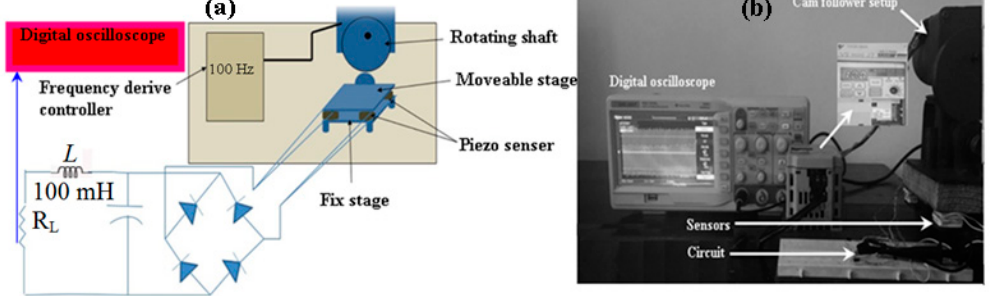
Figure 11. The self-designed cam follower Piezo harvester testing setup. ( a ) The schematic; ( b ) the experimental setup.